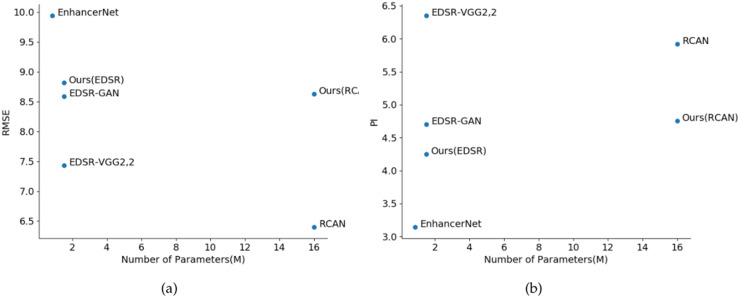
Scatter graph of the number of parameters versus SR performance for our methods and others (Bicubic, EnhanceNet, EDSR, RCAN, EDSR-GAN, EDSR-VGG2,2).Results are evaluated on Set5 with scale factor ×4: (a) is the number of parameters versus RMSE, (b) is the number of parameters versus PI.